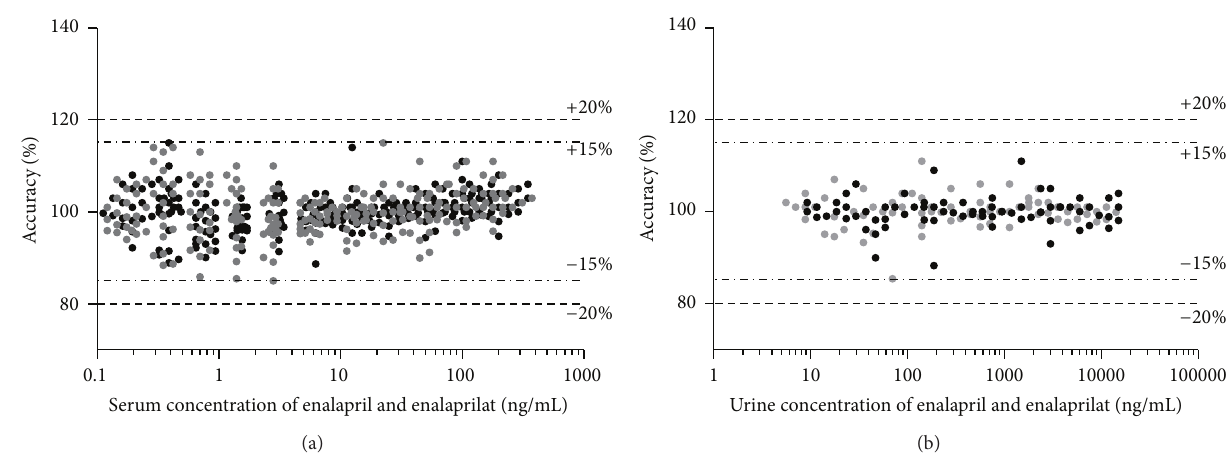
Figure 8: The plots show the accuracy results of 22 serum calibration curves and the accuracy results of 7 urinary calibration curves (each covering 11 concentration levels per drug substance) of enalapril (black) and enalaprilat (grey) used for the evaluation of the obtained results of the conducted Phase I study. Additionally the accuracy thresholds (dashed lines) according to FDA and EMA bioanalytical guidelines for all concentrations levels ( ± 15%) and the LLOQ ( ± 20%) are